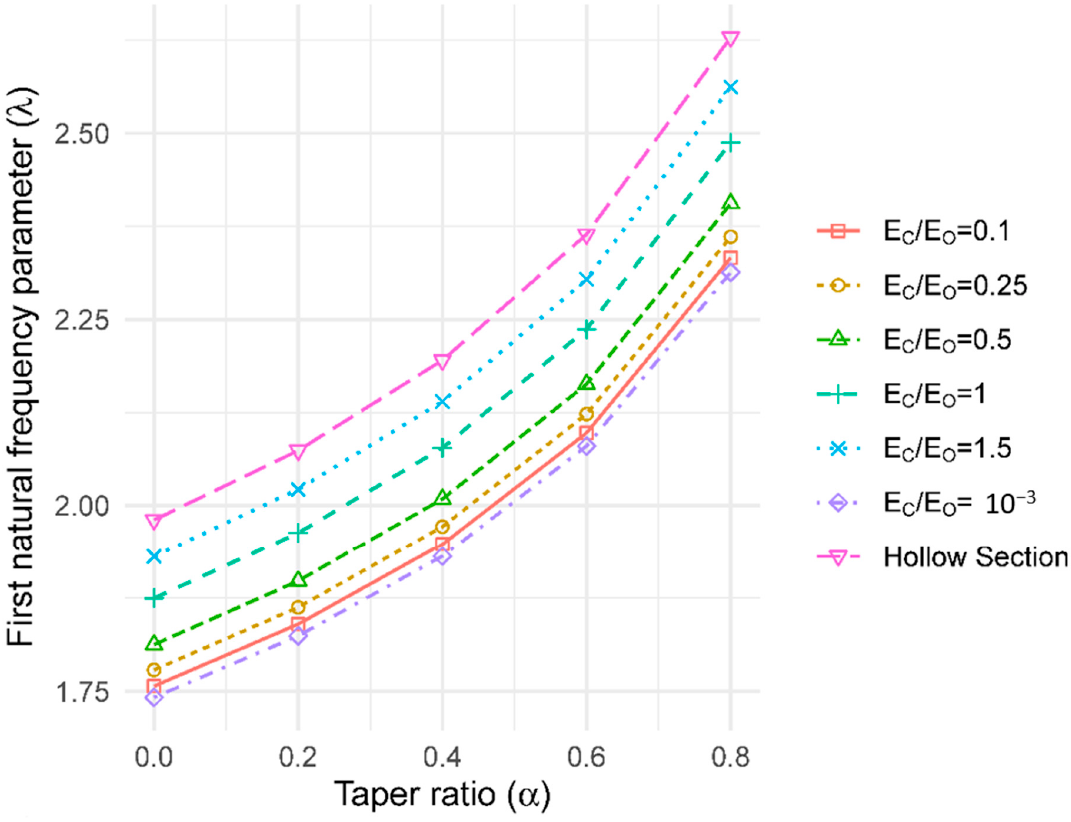
Figure 6. Taper ratio versus first natural frequency parameter ratio with radial sti ff ness